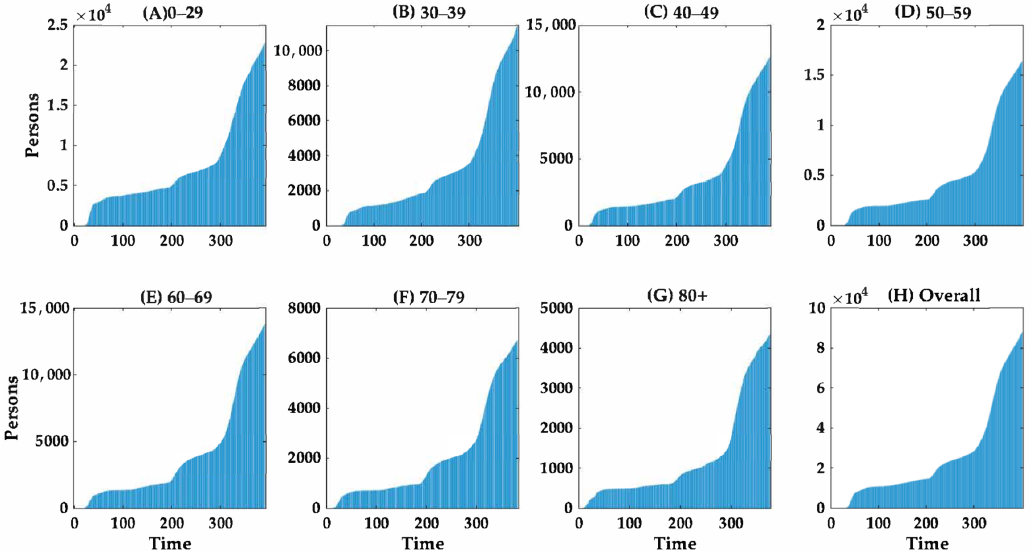
Figure 3. Temporal distribution of cumulative COVID-19 cases according to age group in South Korea from 20 February 2021 to 23 February 2021. The cumulative number of COVID-19 cases are shown according to the following age groups: ( A ) 0–29 years, ( B ) 30–39 years, ( C ) 40–49 years, ( D ) 50–59 years, ( E ) 60–69 years, ( F ) 70–79 years, ( G ) ≥ 80 years and ( H ) all cases. Day 1 corresponds to 20 February 2021. The scale on the Y -axis differs according to age group.